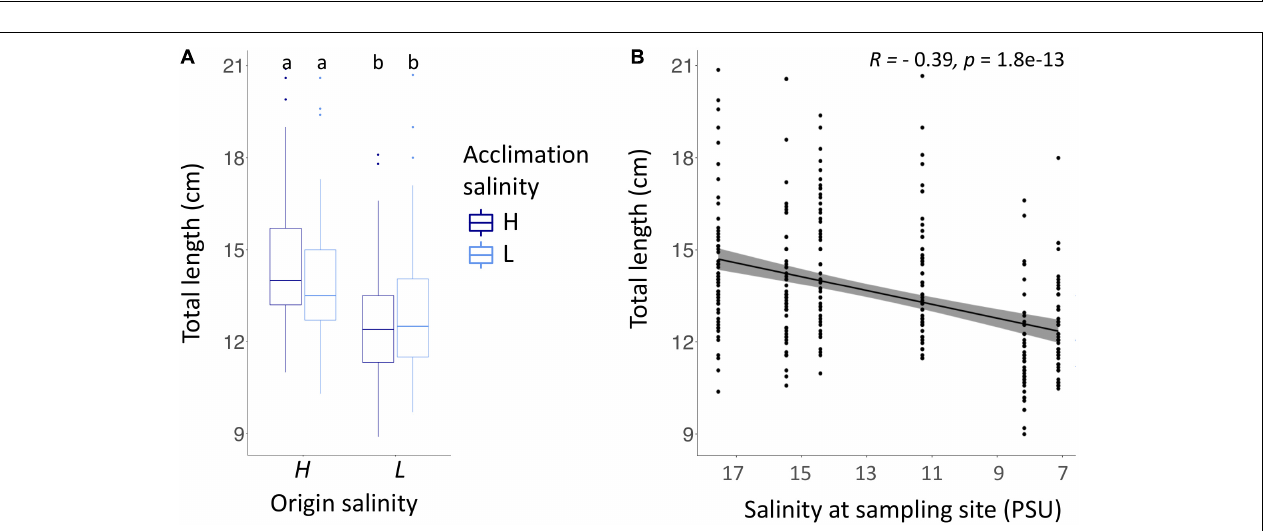
FIGURE 3 | Body length of adult pipefish (A) correlated with salinity at the sampling site (B) . (A) The total length of pipefish is shown for both origin salinities (high (H) – 15 PSU, low (L) – 7 PSU). Colors indicate whether the parental generation was exposed to a high (H, dark blue) or to low acclimation salinity (L, light blue). (B) The total length of pipefish after acclimation correlated with the salinity measured at the sampling site using spearman rank correlation. Gray bar indicates 95% confidence interval.